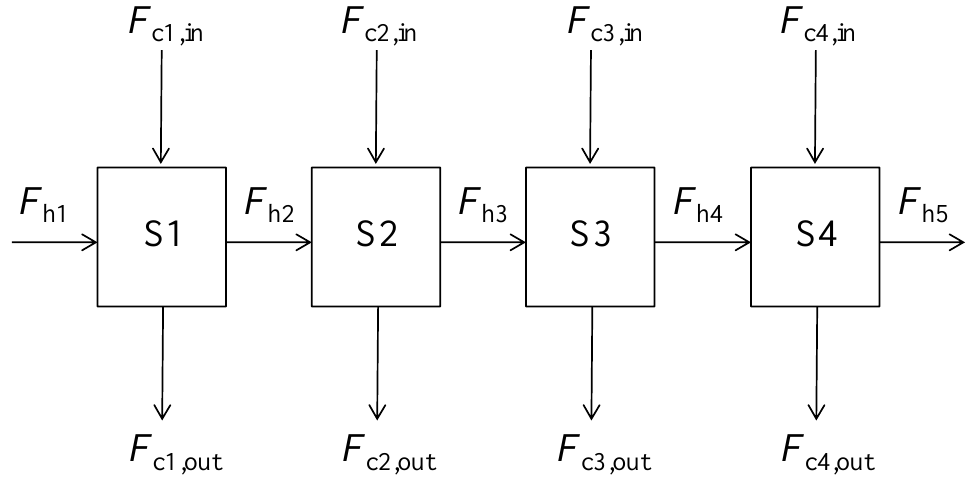
Figure 3. Schematic diagram of the multi-stage condensers model. Therefore, the key was to reasonably establish the relationship between the output fluid parameters of each stage and all external input fluid parameters before this stage. In actual operation, the mass flow rate and temperature of the input hot fluid F h1,in and the input cold fluids F c1,in , F c2,in , F c3,in , and F c4,in of each stage condenser were fixed values. When the structure parameters of the condensers were determined, the mass flow rates and temperatures of the output hot fluid F h1,out ( F h2,in ), F h2,out ( F h3,in ), and F h3,out ( F h4,in ), and the final output fluid F h4,out ( F h5 ) were only related to the input